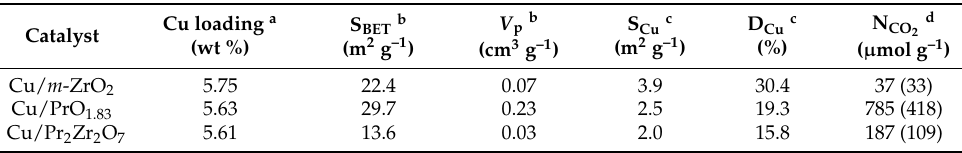
Table 1. Characteristics of the prepared Cu catalysts.